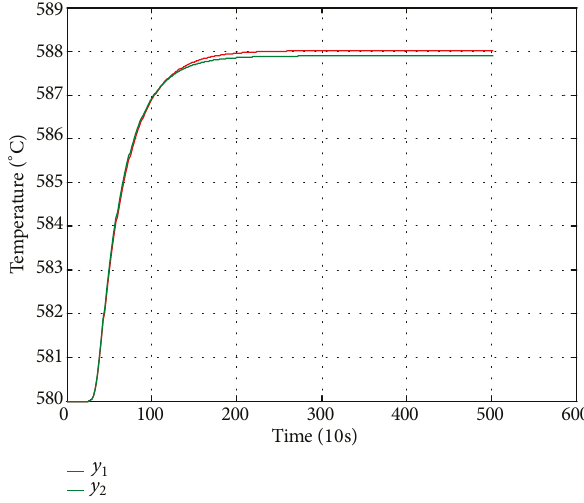
Figure 7: The variation curve of reheatsteam temperaturewhen the load of generator unit is 400MW, 𝑢 𝑗 ∈ [0,6],Δ𝑢 𝑗 = 0.5